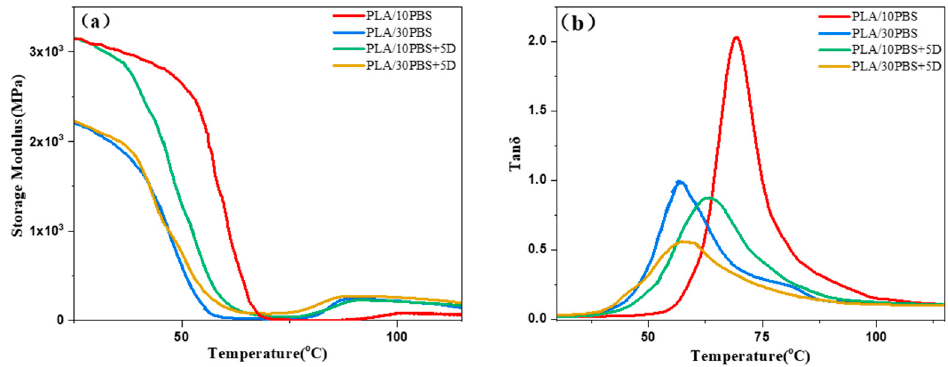
Figure 4. Temperature dependence of ( a ) the storage modulus and ( b ) tan δ for PLA/PBS blends with or without PDLA.